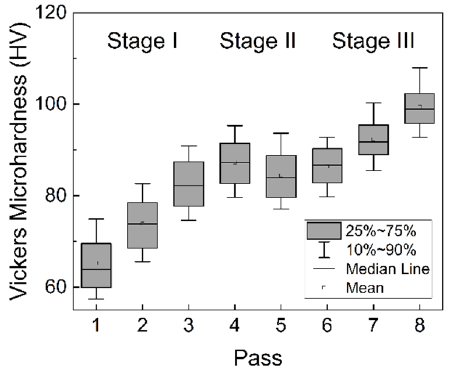
Figure 4. Variation in Vickers microhardness values depending on the number of applied MPCR deformation passes.